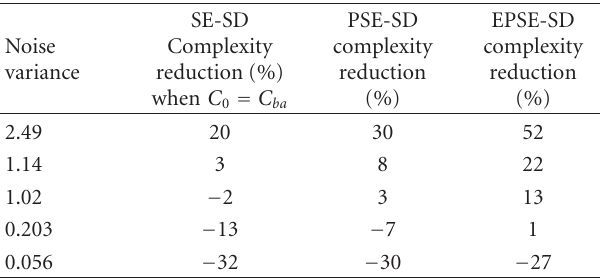
Table 2: Reduction in complexity corresponding noise variance.